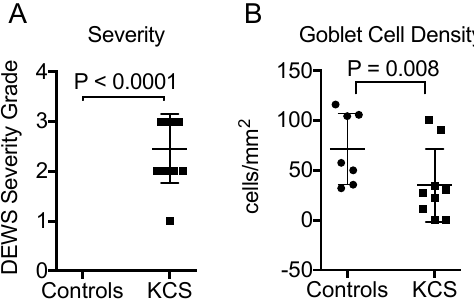
Figure 1. Clinical severity ( A ) and conjunctival goblet cell density ( B ) in controls ( n = 7) and Sjögren’s syndrome keratoconjunctivitis sicca (KCS) subjects ( n = 9). Mean + standard deviation (SD).